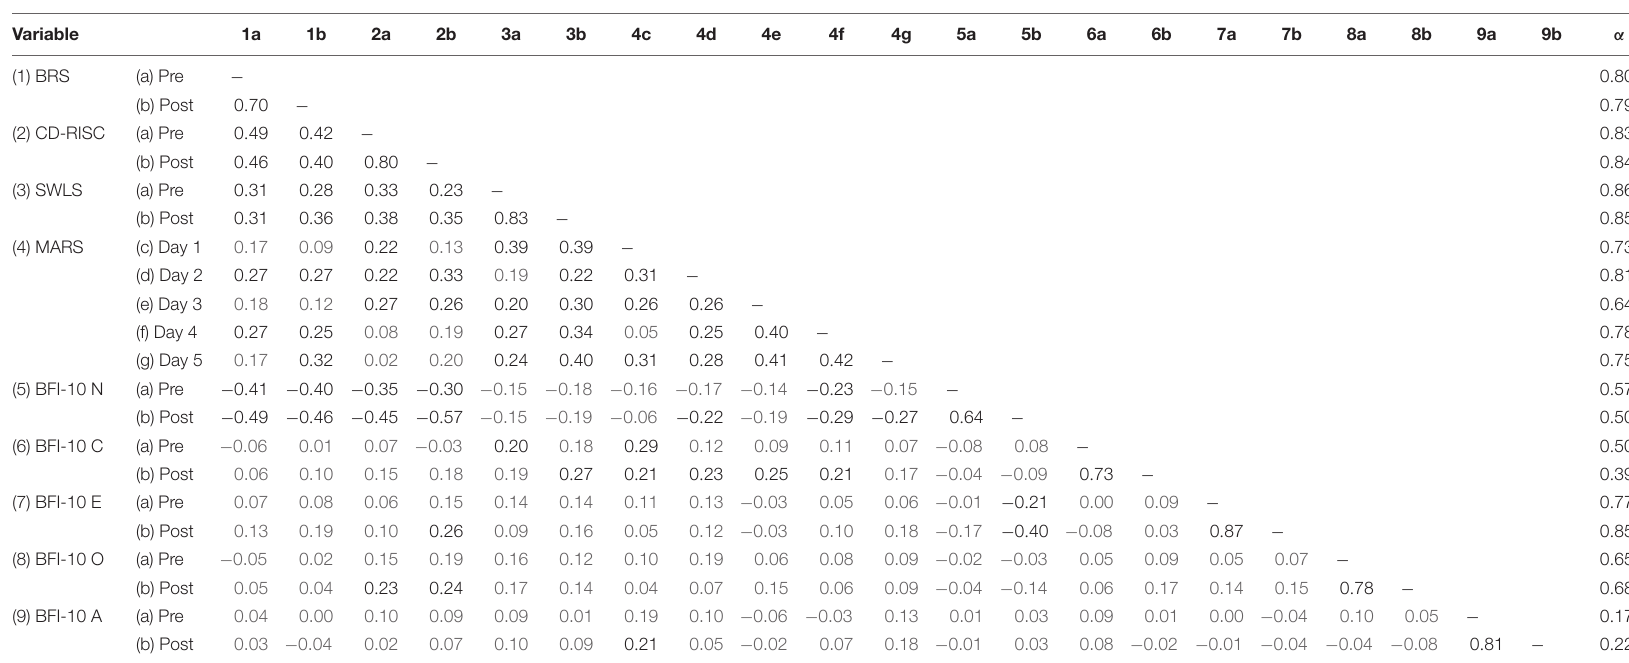
TABLE 2 | Pre-post variables: correlations and Cronbach’s alpha.